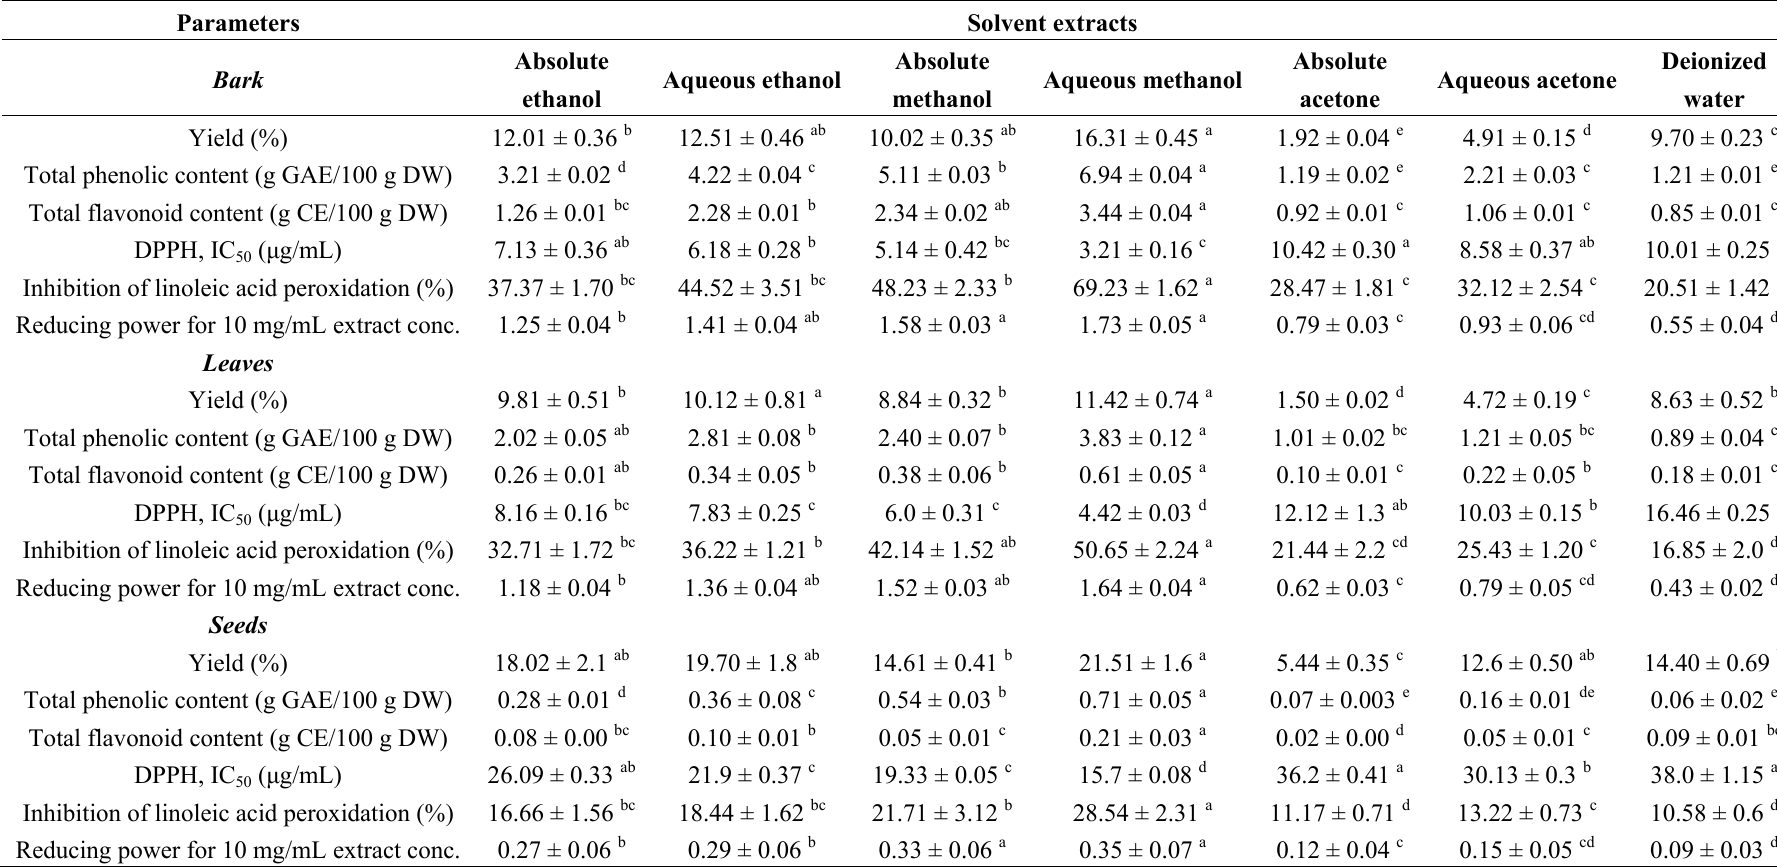
Values are mean ± SD of three separate experiments. Different superscript letters within the same row indicate significant ( p < 0.05) differences of means within the extracting